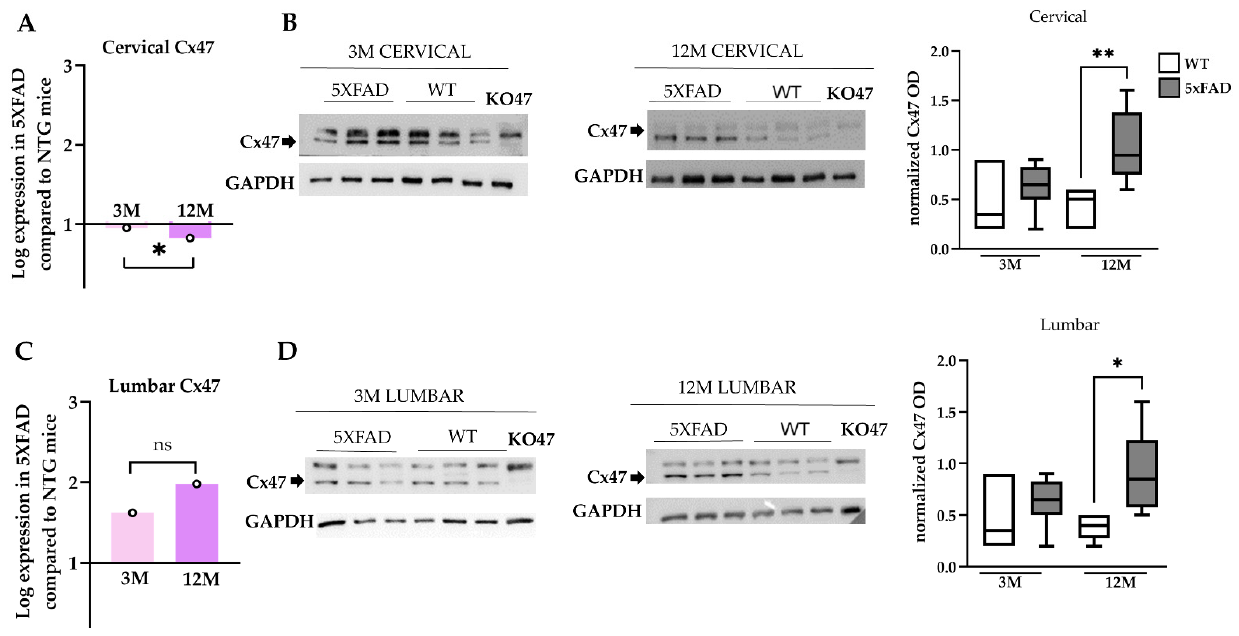
Figure 9. Cx47 mRNA and protein levels in the spinal cord of 5xFAD mice. Real-time PCR of Cx47 mRNA transcript levels in cervical ( A ) and lumbar ( C ) spinal cord sections of 3M and 12M 5xFAD and WT mice. The asterisks inside the columns of mRNA graphs indicate the p -values representing significance of connexin levels in 5xFAD compared to WT controls, while the asterisks outside the columns show the significance between different age groups of 5xFAD mice. ( B , D ) Quantification of normalized band optic density (OD) revealed increased Cx47 protein levels in 12M 5xFAD mice compared with the WT control group in both spinal cord sections. β -Tubulin was used as an internal control for the mRNA analysis, and GAPDH was used as a loading control for the immunoblot analysis. Statistical analysis for the mRNA was performed by unpaired t -test and for the immunoblots was performed by one-way ANOVA followed by Kruskal–Wallis multiple comparisons test ( n = 6 for all genotype and age groups). Data are presented as mean ± SD. Significance is given as: * p < 0.05, ** p < 0.01.